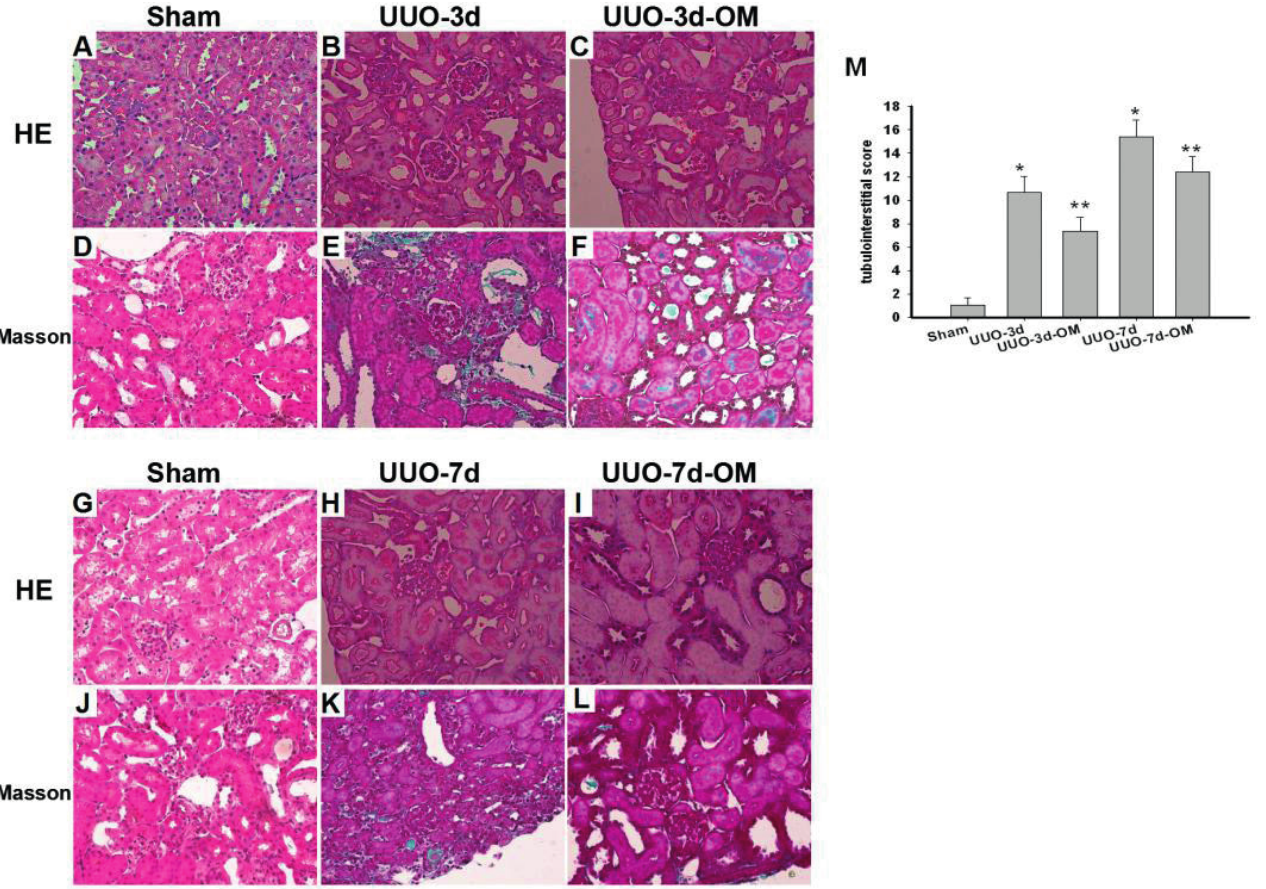
FIGURE 2 - HE/Masson staining (A- L) and tubulointerstitial score (M) of Sham, UUO-3d or UUO-7d with or without OM